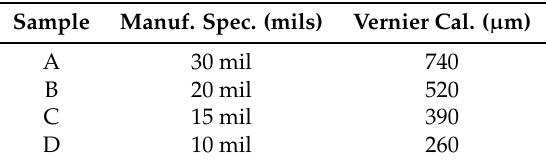
Table 1. Four samples of thin polycarbonate films (layer d 1 in Figure 1) were evaluated in this study. Each of the samples was measured with a digital Vernier caliper. The mean of 10 measurements for each sample film is listed in the